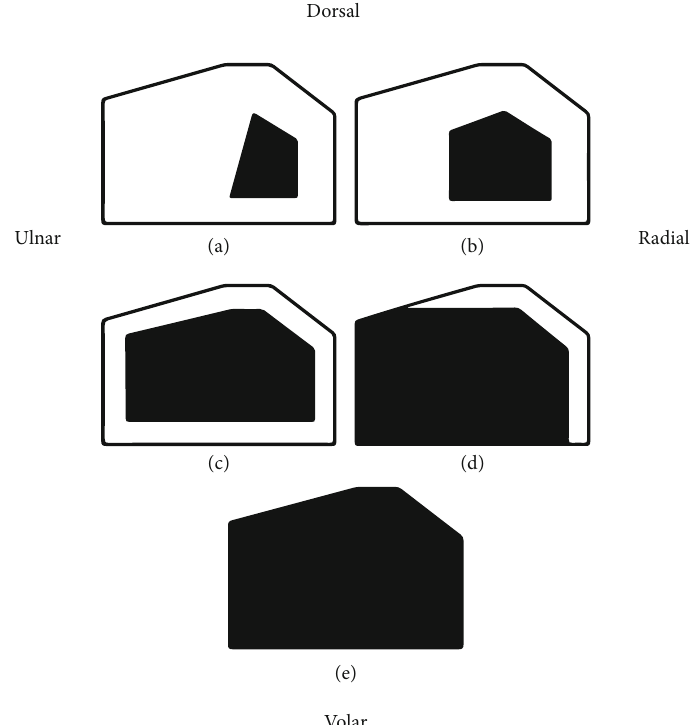
Figure 5: Sequence of fusion of the distal radial physis as identi fi ed by Kraus et al. [7]. Reprinted with